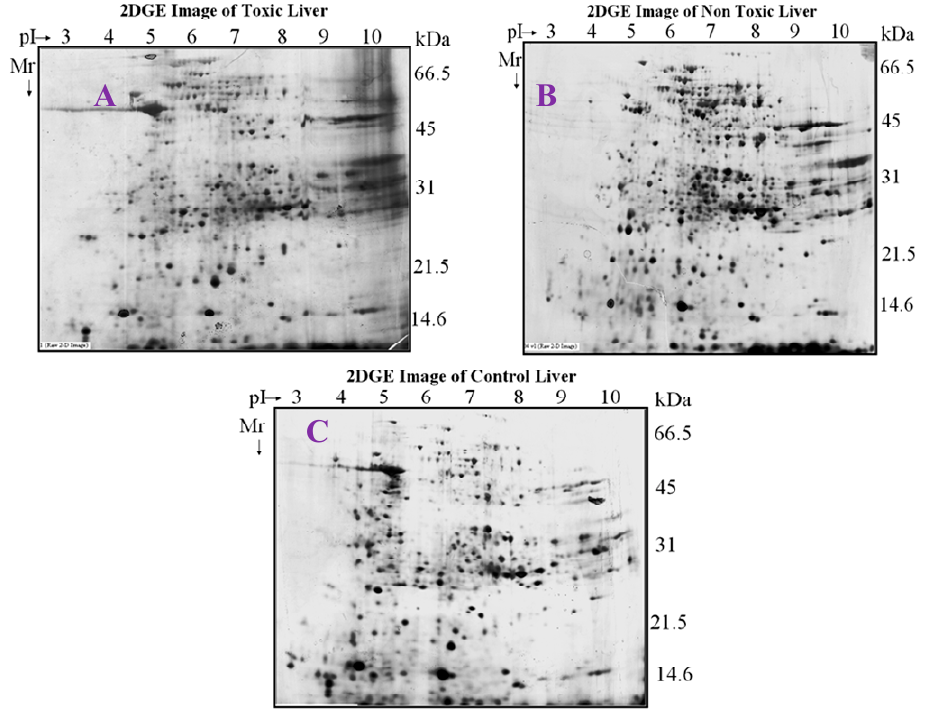
Figure 2. 2D map of experimental rat liver. Liver proteins were separated by pH gradient 3–10 by 12% SDS-PAGE. A —Control, B —Non-toxic dose (150 mg/kg), C —Toxic dose (1500 mg/kg). Spots in the gel were cut and the corresponding proteins identified were indicated in Figure 3A.